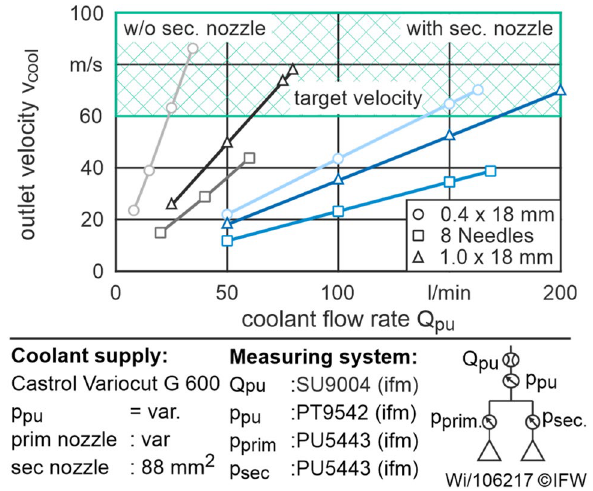
Fig. 8 Coolant flow rates and resulting outlet velocities for different nozzle